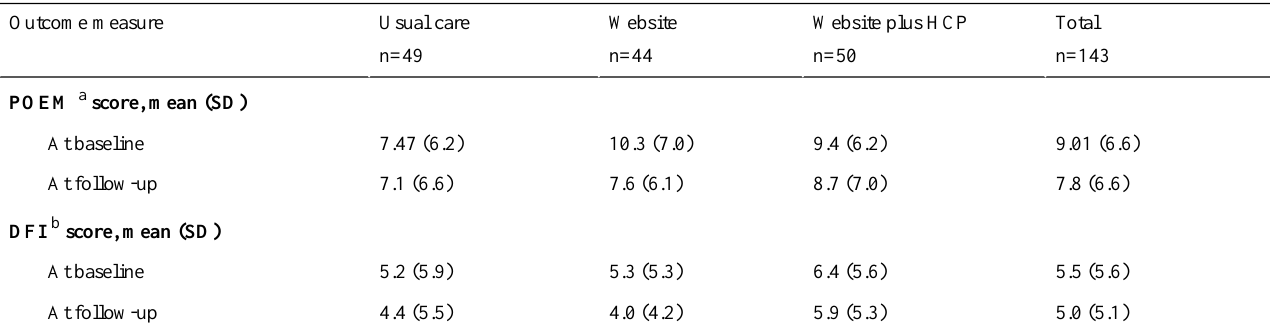
Table 4. Patient-Oriented Eczema Measure (POEM) and Dermatitis Family Impact (DFI) scores at baseline and at 3-month follow-up.